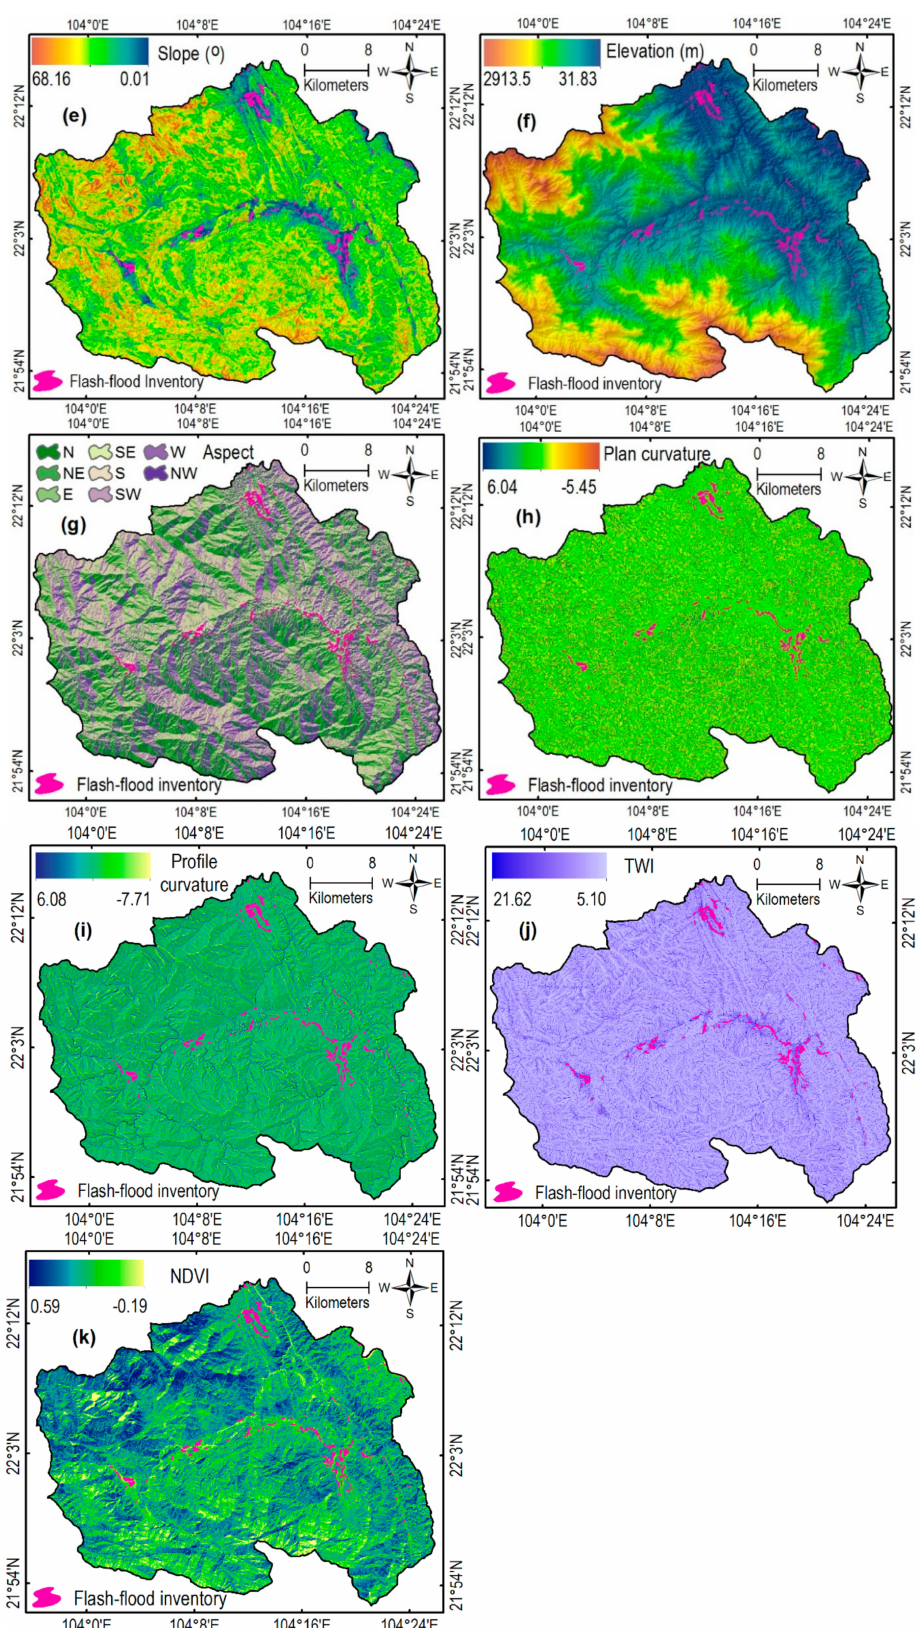
Figure 2. Flood influencing factors: ( a ) geology; ( b ) soil type; ( c ) river density; ( d ) rainfall; ( e ) slope; ( f ) elevation; ( g ) aspect; ( h ) plan curvature; ( i ) profile curvature; ( j ) TWI; ( k )